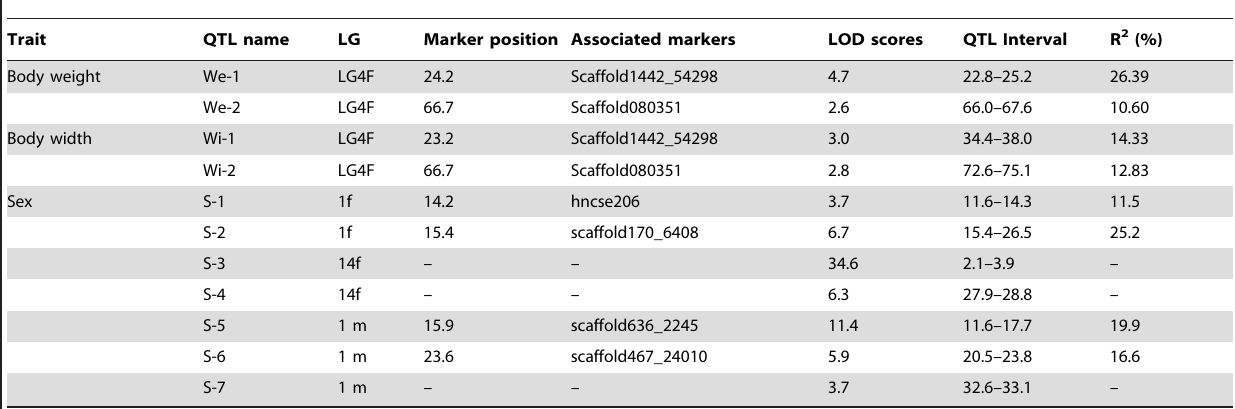
Table 3. Biometrical parameters of individual QTL affecting growth traits and sex of half-smooth tongue sole.